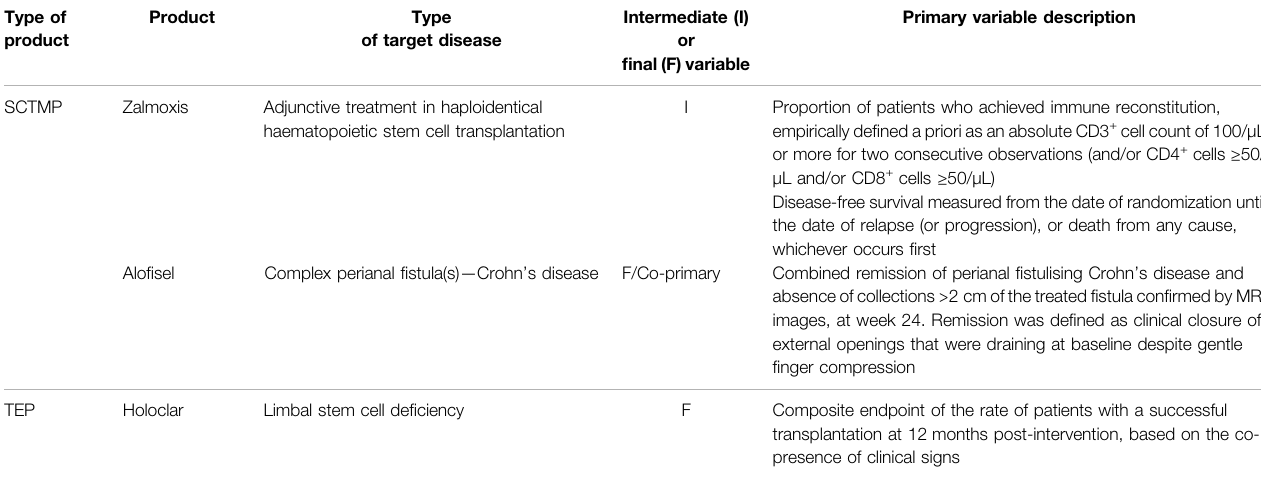
TABLE 5 | ( Continued ) Primary clinical variables of pivotal clinical trials for the approved ATMPs in the European